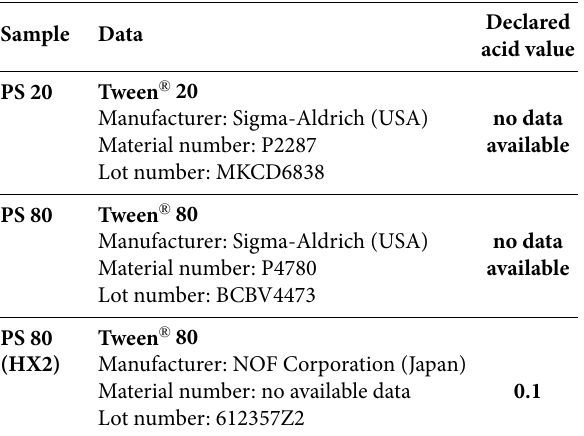
Table 1. Analysed fresh PS